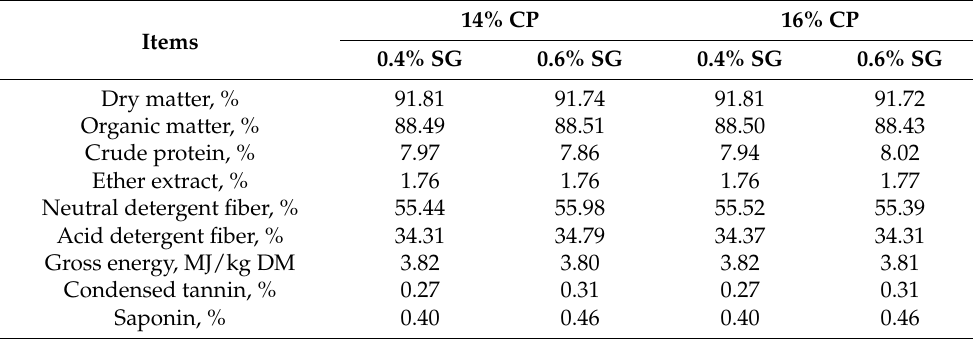
Table 2. Chemical compositions of the rations based on dry